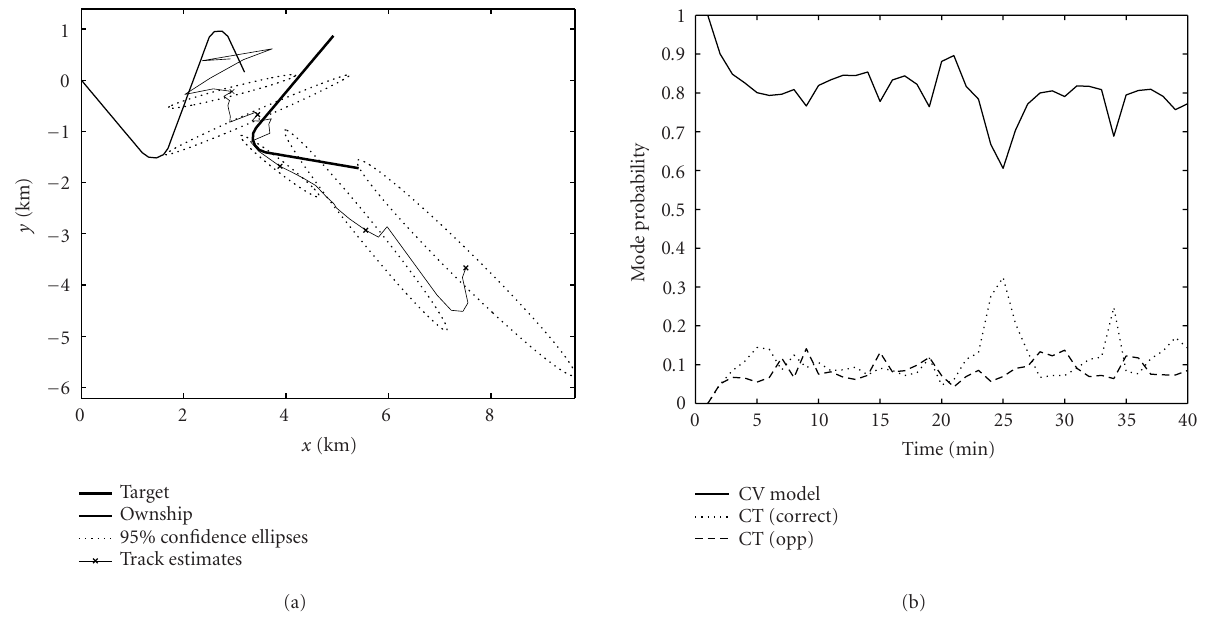
Figure 3: IMM-EKF tracker results. (a) Track estimates and 95% confidence ellipses. (b) Mode probabilities.